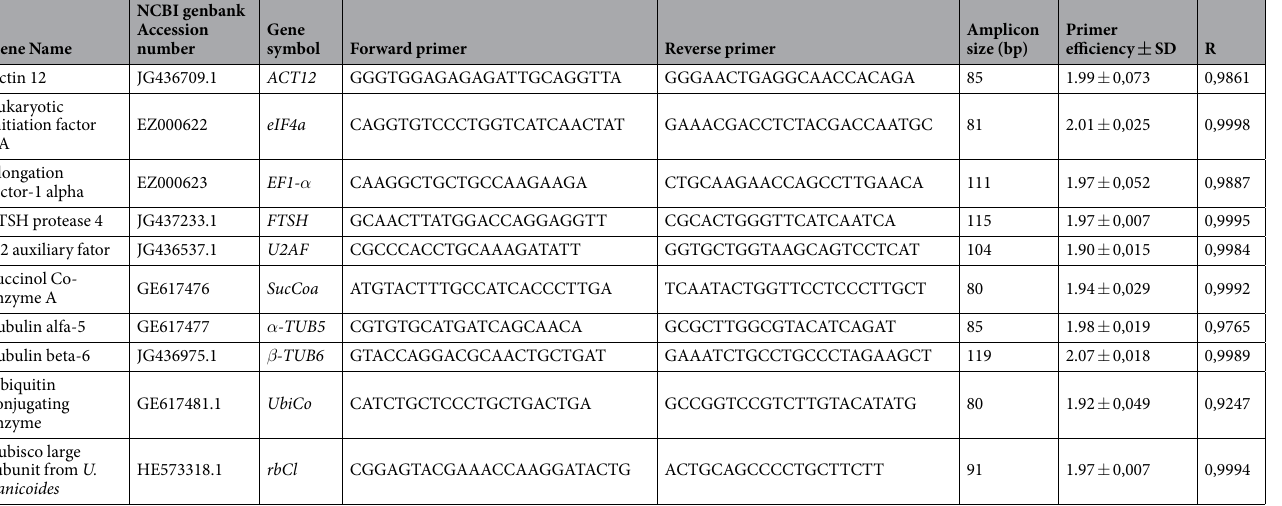
Table 1. List and description of the genes used in this study. Primer sequences (5 ′ –3 ′ ) employed in the RT– qPCR analysis, amplicon sizes and LinRegPCR-derived PCR efficiency